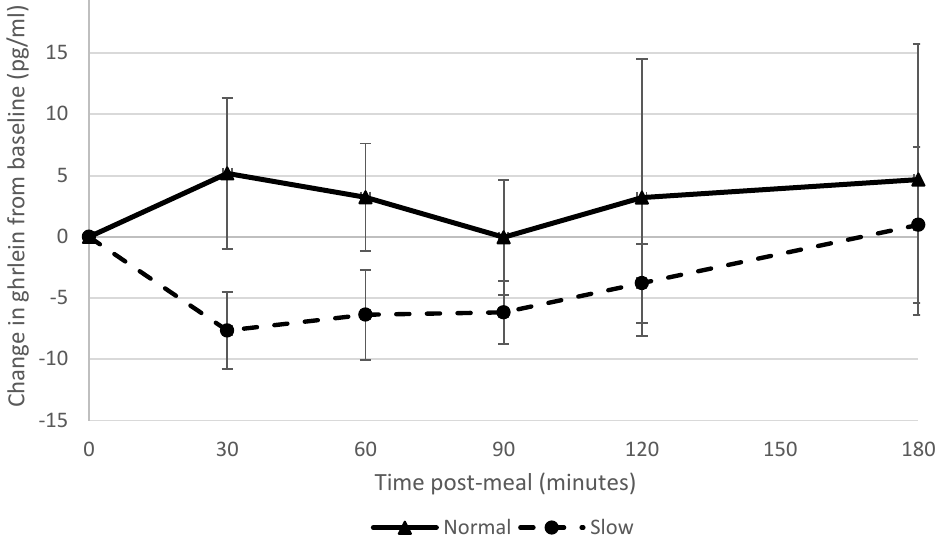
Figure 4a. Ghrelin suppression over time in normal and slow rate groups.